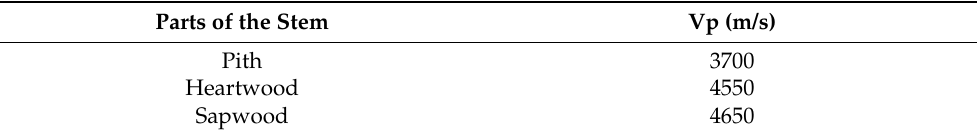
Table 1. Mean velocity values (Vp) of longitudinal ultrasonic signals characterizing the different anatomic parts of a healthy holm oak sample.